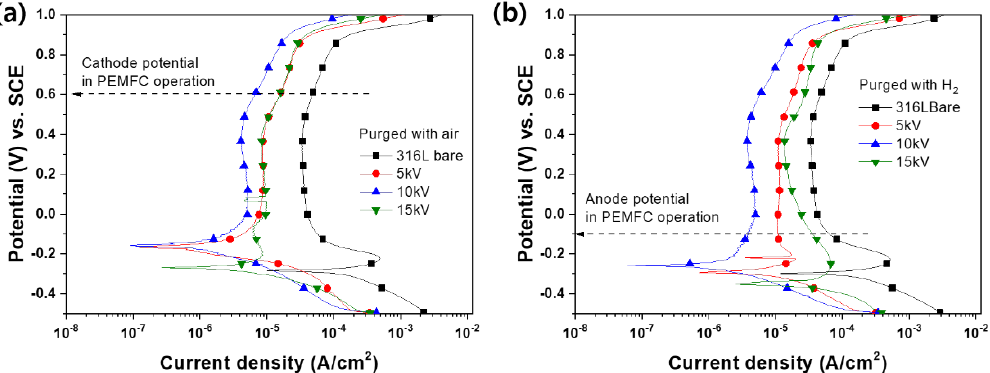
Figure 5. Potentiodynamic polarization curves of N + -implanted samples in 0.5 M H 2 SO 4 at 70 °C with purged ( a ) air and ( b ) H 2 .